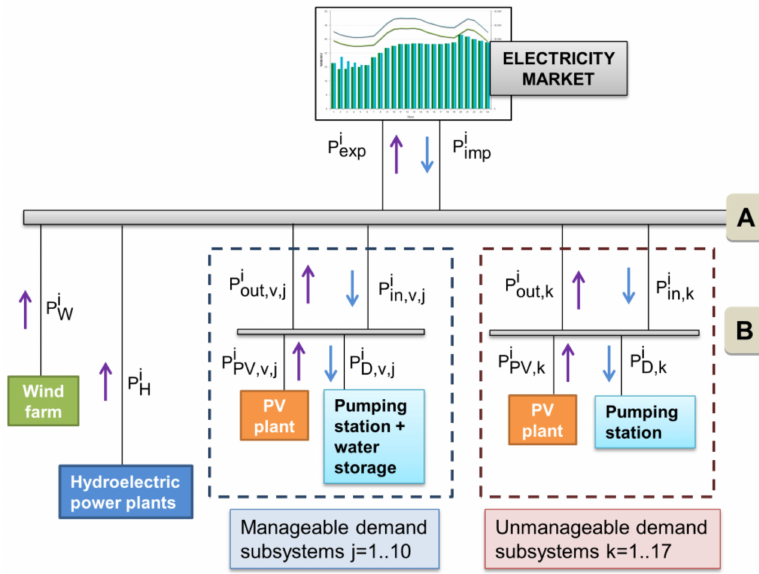
Figure 2. Energy flow diagram of the proposed